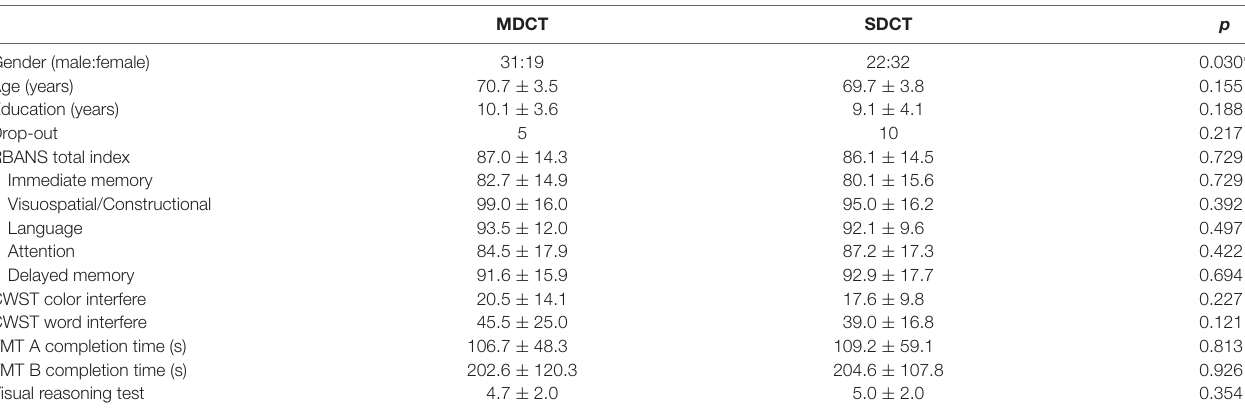
TABLE 1 | Demographic characteristics and baseline cognitive function by training group.